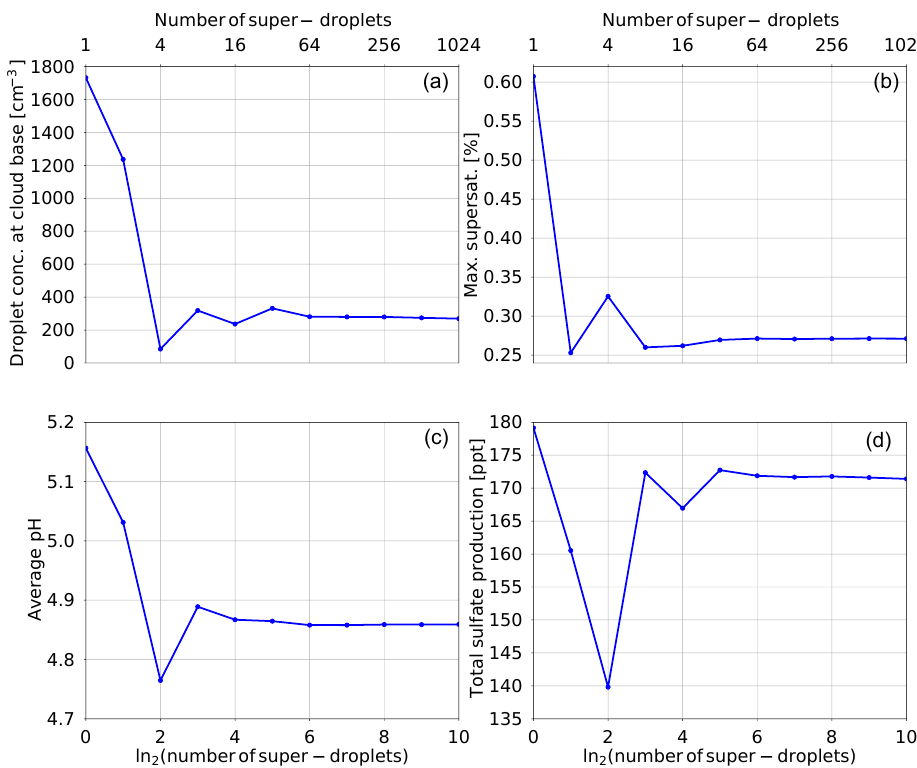
Figure 2. Results of the convergence test for the adiabatic parcel simulations. All panels show how a given parameter depends on the number of SDs (shown on the abscissa as the logarithm of base 2 of the number of SDs). Panel (a) shows the cloud droplet concentration at the cloud base, panel (b) the maximum supersaturation, panel (c) the water volume weighted average pH at the end of simulation, and panel (d) the total sulfate production.